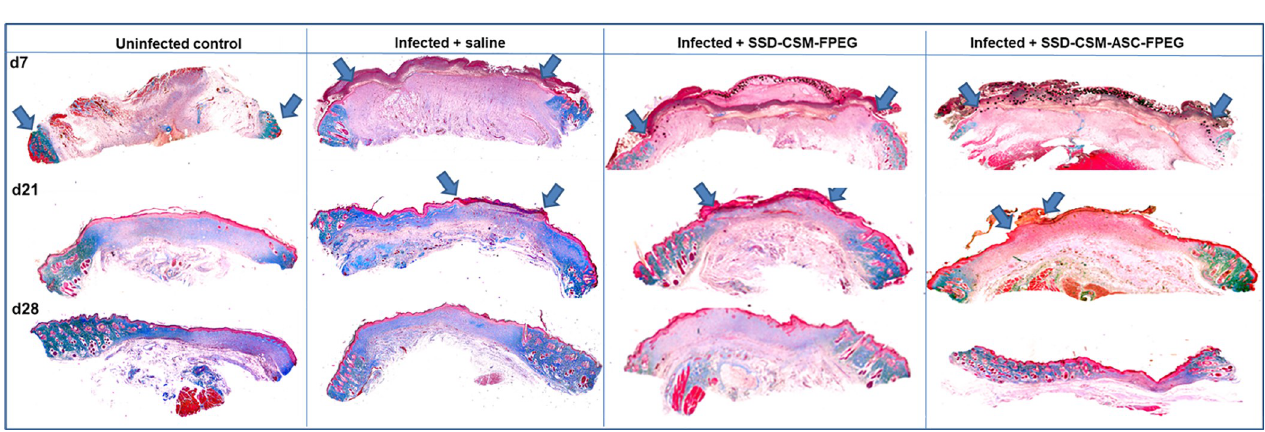
Fig 6. Wound closure characteristics. Representative Masons trichrome showing wound histology on day 7, day 21 and day 28. Interpretation of Masons trichrome staining is as follows: red: keratin and muscle fibers; blue or green: collagen and bone; light red or pink: cytoplasm; and dark brown to black: cell nuclei. SSD-CSM-ASC-FPEG treated samples was observed to have a significantly thicker granulation tissue ( n = 4).